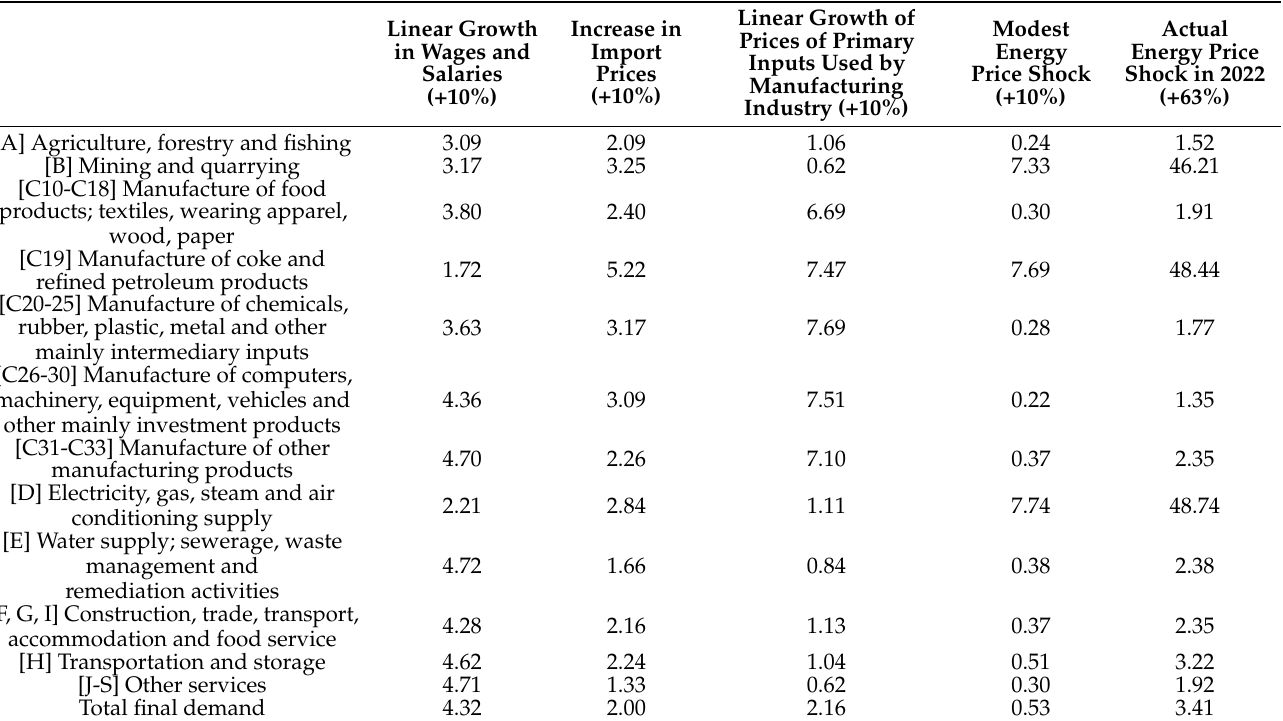
Table 1. Comparison of effects of different types of exogenous shocks on prices of final goods and services produced in Croatia. Source: